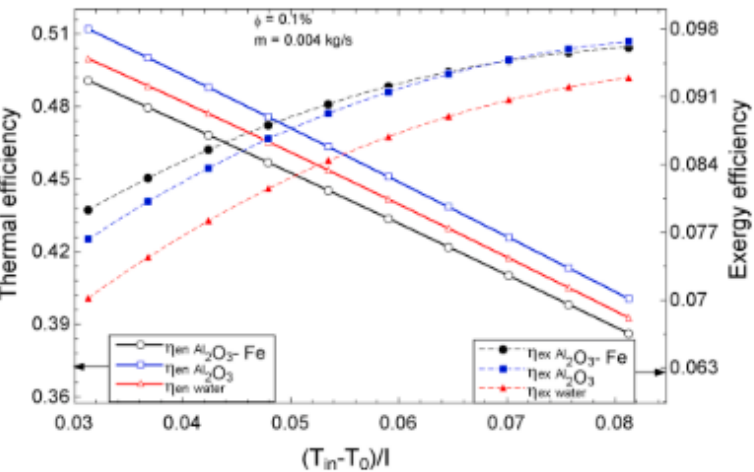
Figure 10. Thermal and exergetic efficiency performance of Al 2 O 3 ‐ Fe nanofluid against temperature parameter for a flat plate collector application (Adapted from Okonkwo et al. [112]).